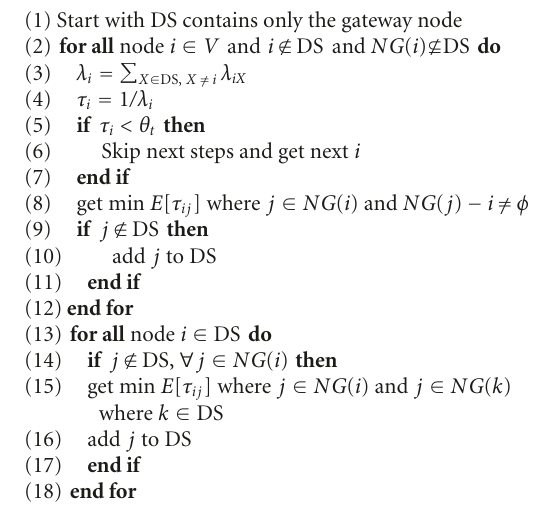
Table 2: Intermeeting time (simulation